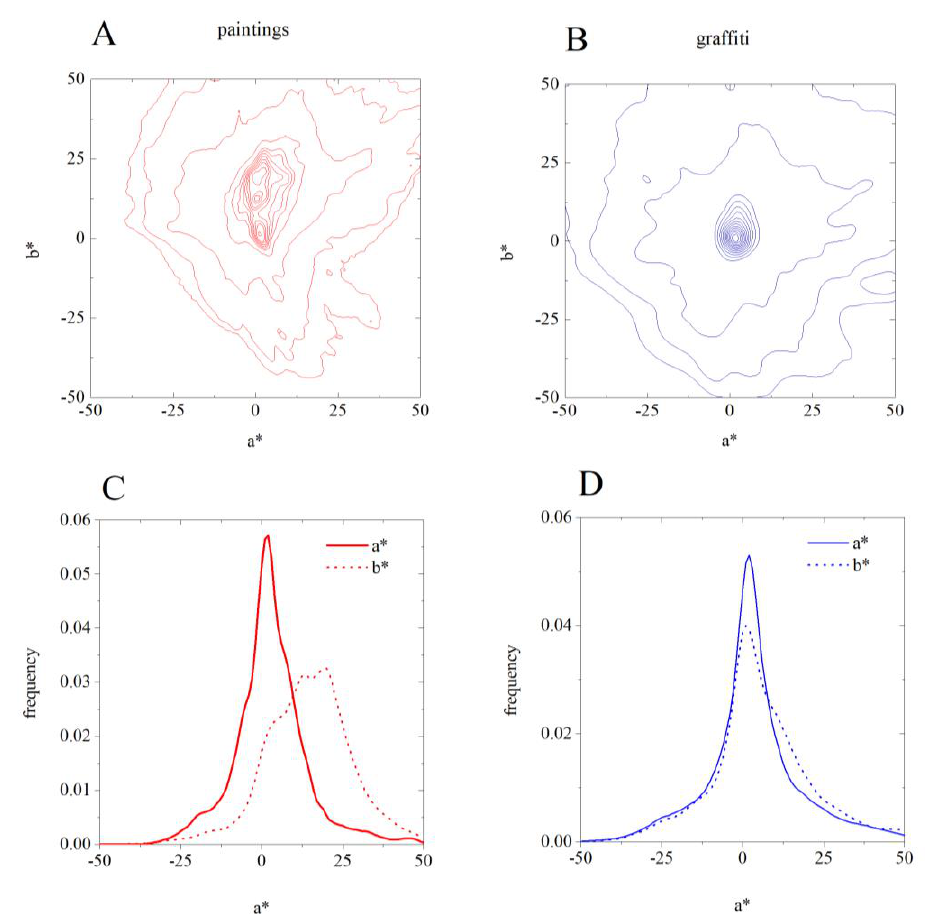
Figure 9. Distribution of the colors in paintings ( A , C ) and graffiti ( B , D ). Upper panel: contour lines of the frequency of occurrence of the colors in paintings ( A ) and graffiti ( B ). Lower panel: histograms for a* and b* for paintings ( C ) and graffiti ( D ).